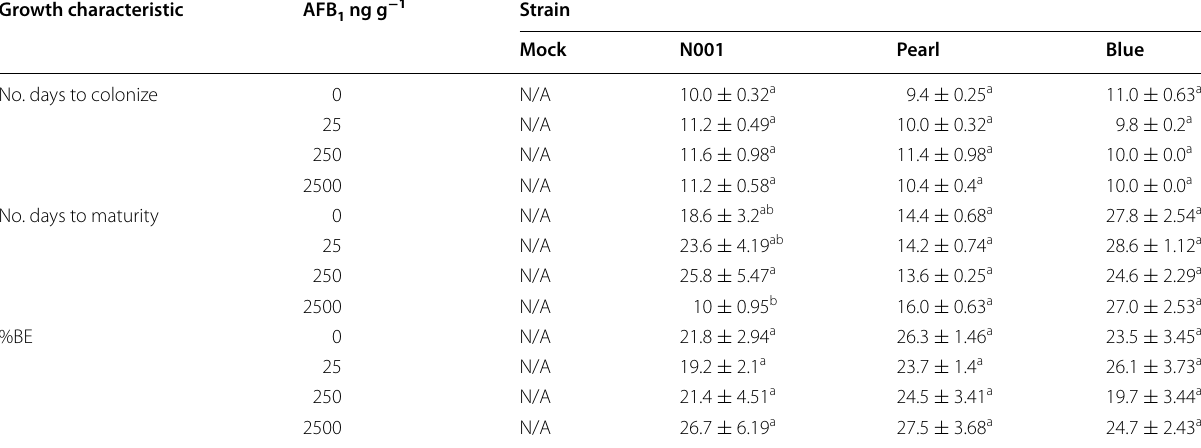
Values represent the mean standard error. Values not followed by the same letter within columns of the same category are significantly different ( p < 0.05) by Tukey’s ± HSD